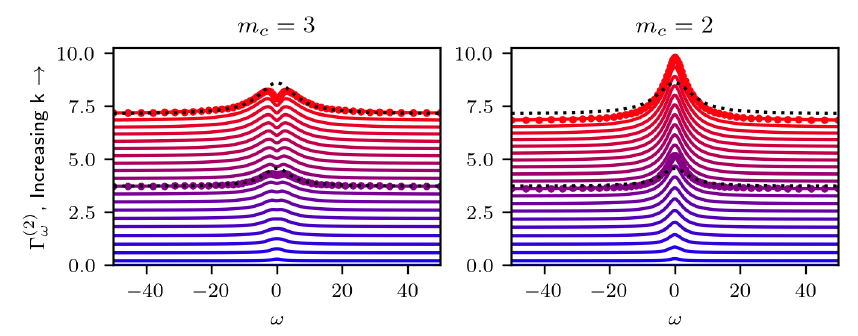
= 2,3 with exact c = 3 case. Black c